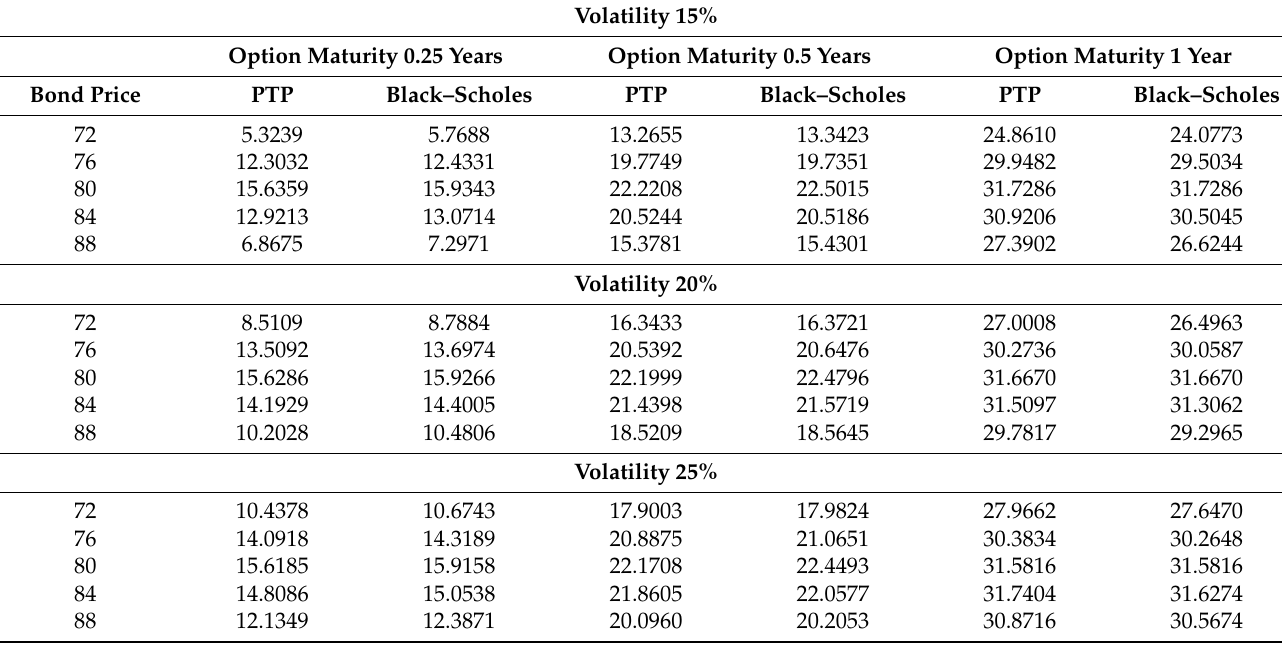
Table 6. Comparison of PTP vegas to Black–Scholes: strike price 80, risk-free rate 0.5%, bond maturity 20 years.